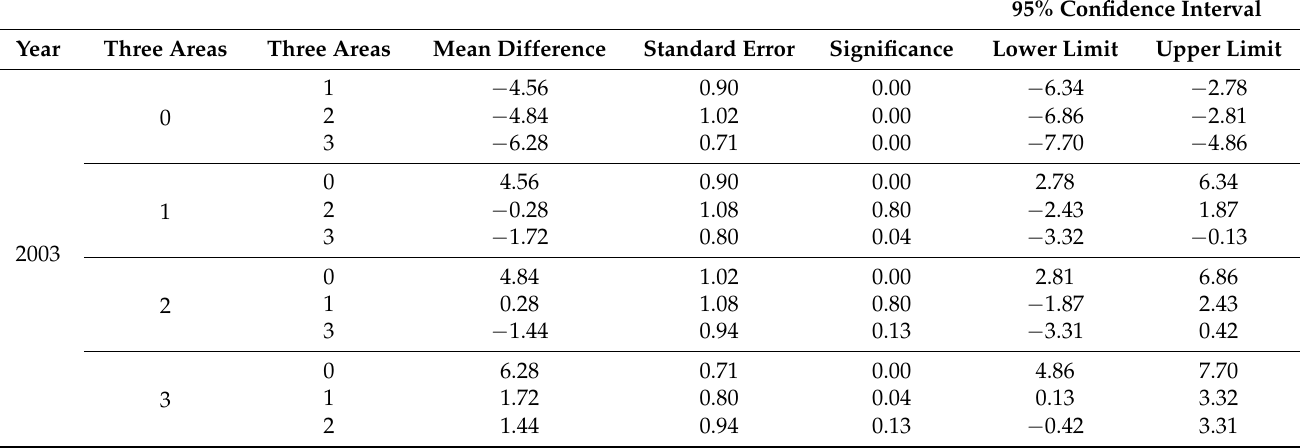
Table A3. Multiple comparison table of LSD method between areas and non-areas in Guizhou province from 2003 to